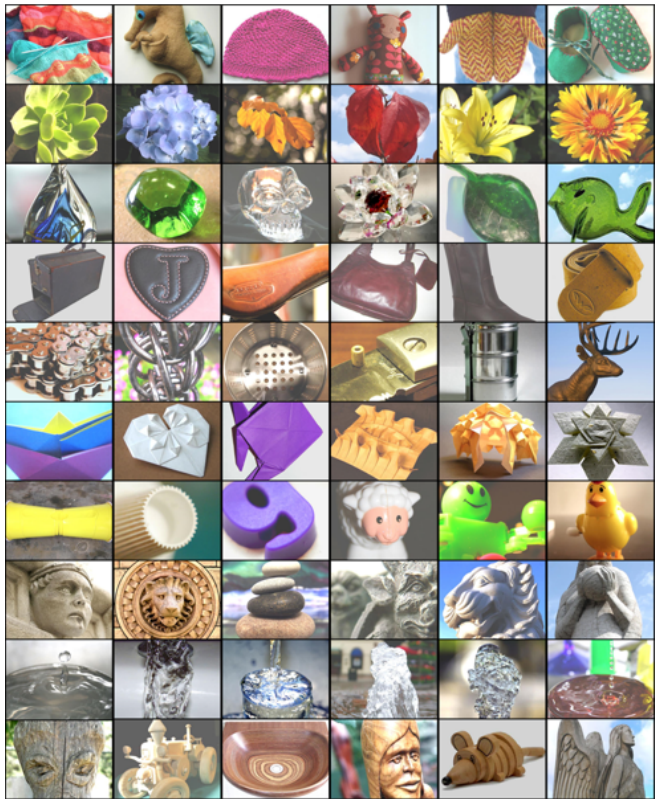
Figure 3. Example images from the ten material classes used in this paper. Each row depicts images from the same class, from top to bottom: fabric, foliage, glass, leather, metal, paper, plastic, stone, water, and